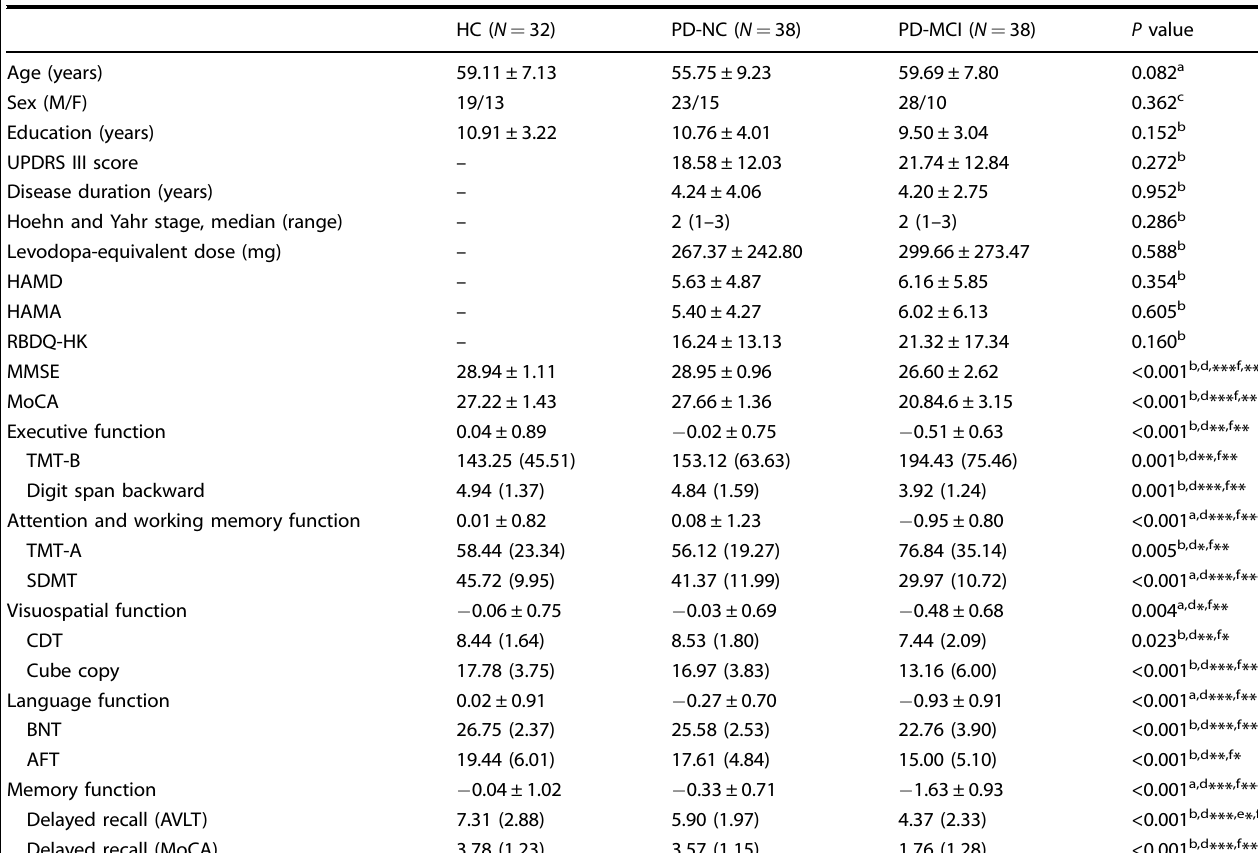
Table 1. Demographic, clinical, and cognitive characteristics of the